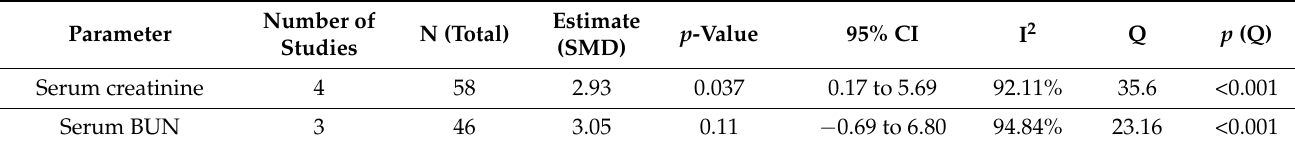
Table 2. Summary of meta-analysis